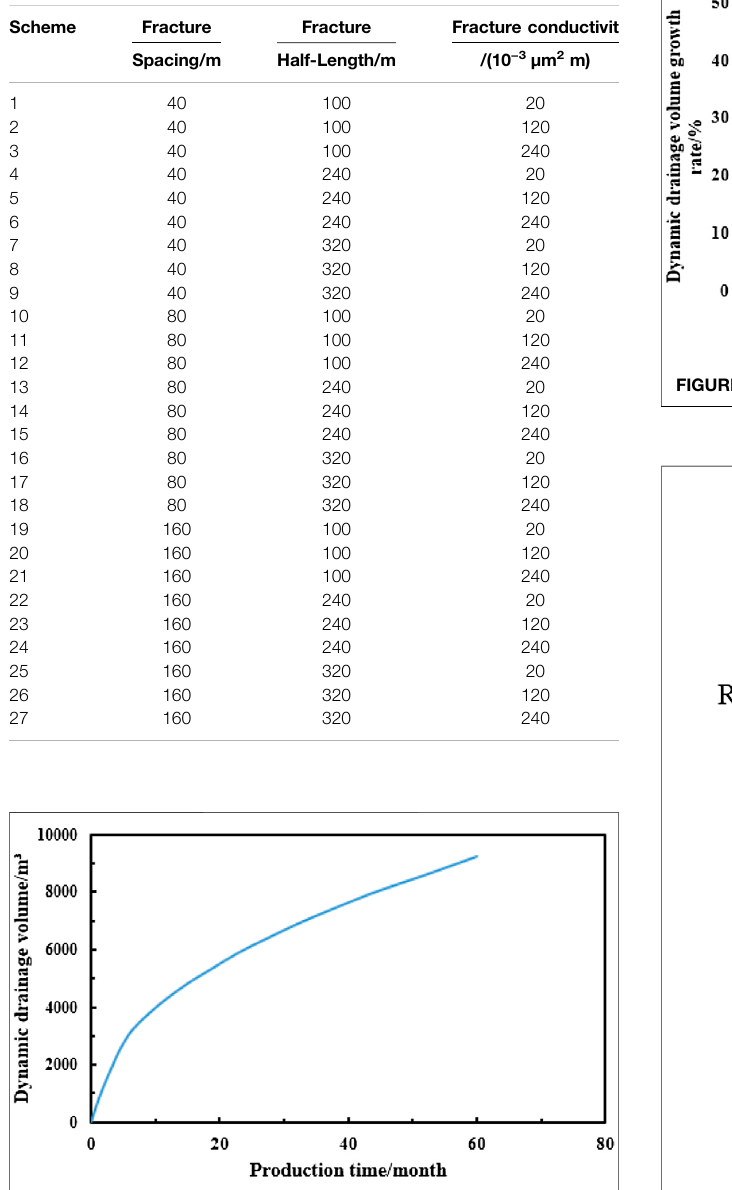
TABLE 3 | Initial fracturing scheme of depleted development.